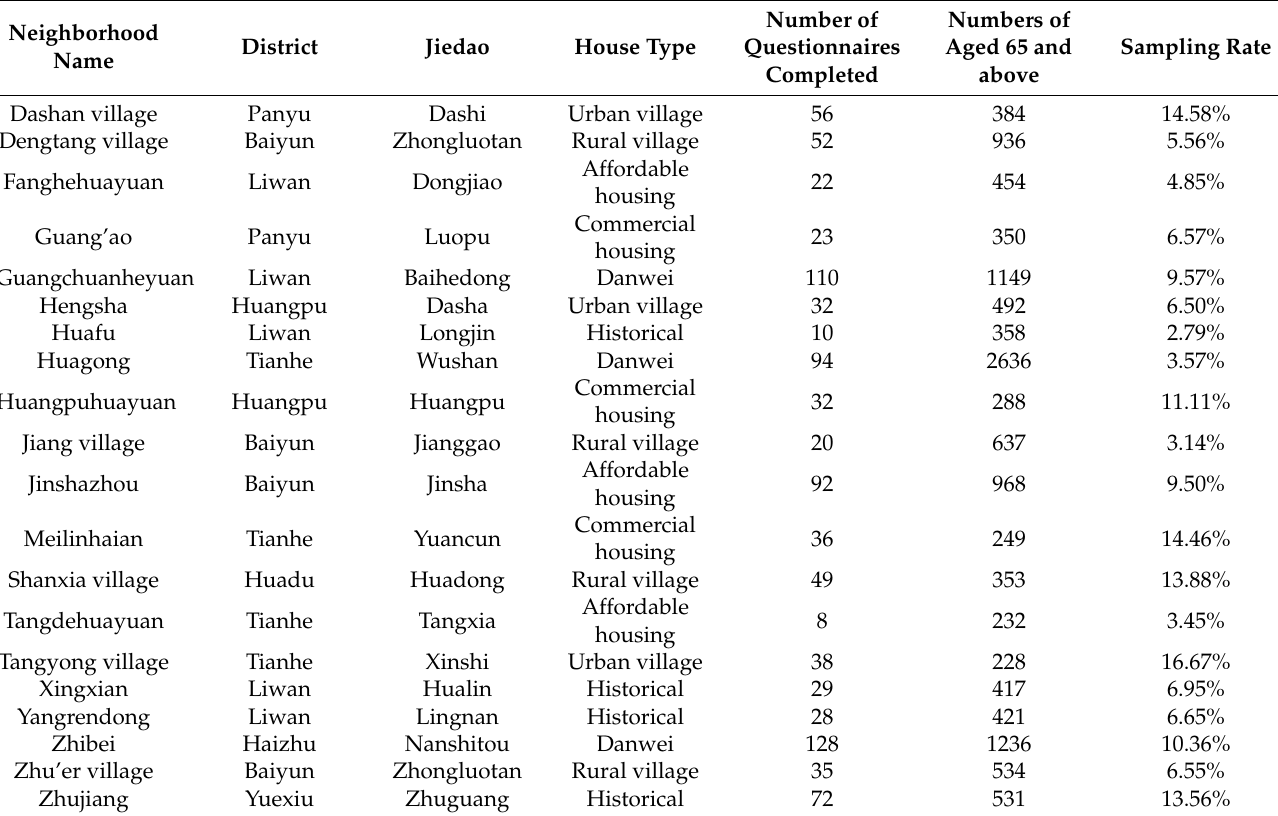
Table 1. Summary statistics for the sampled